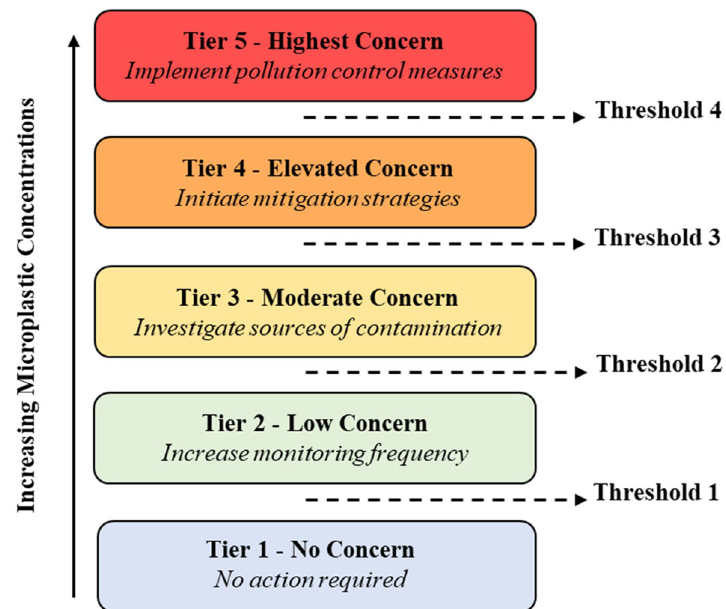
Fig. 1 Proposed tiered management framework to implement health-based thresholds for